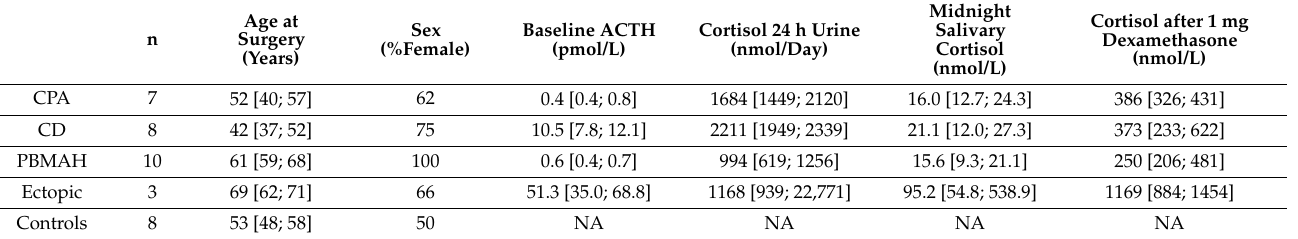
Table 2. Clinical characteristics of the patient groups. Data are given as median with 25th and